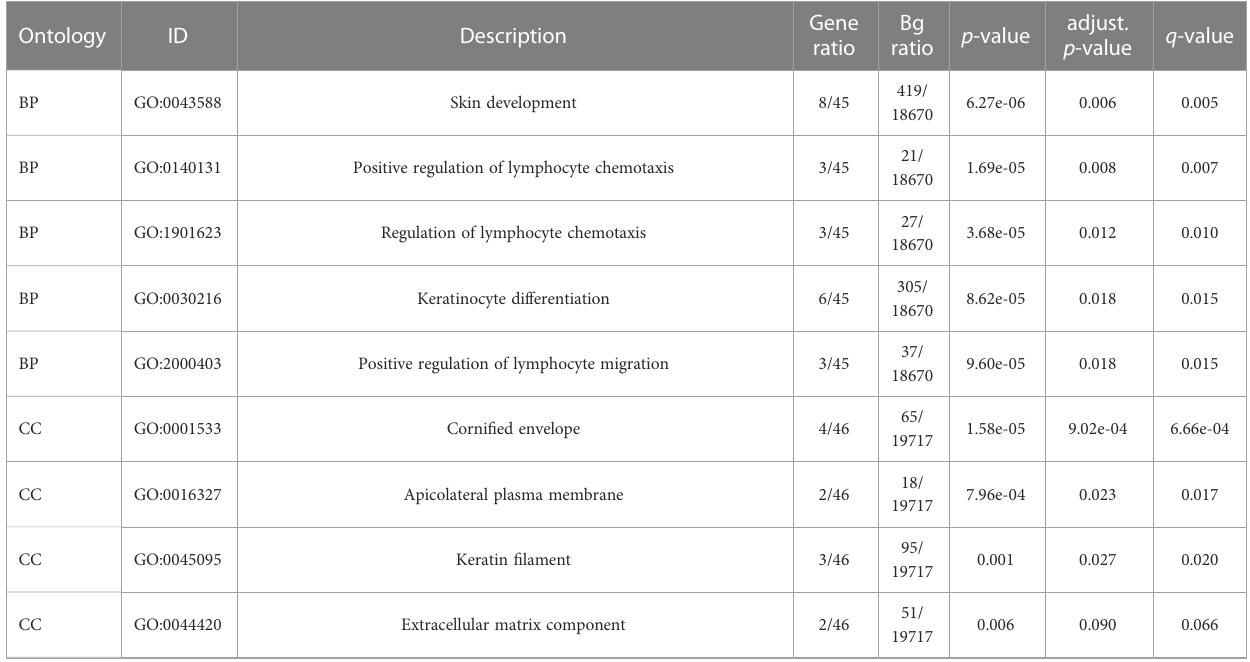
TABLE 1 Gene Ontology (GO)/Kyoto Encyclopedia of Genes and Genomes (KEGG) enrichment analysis of 48 overlapping